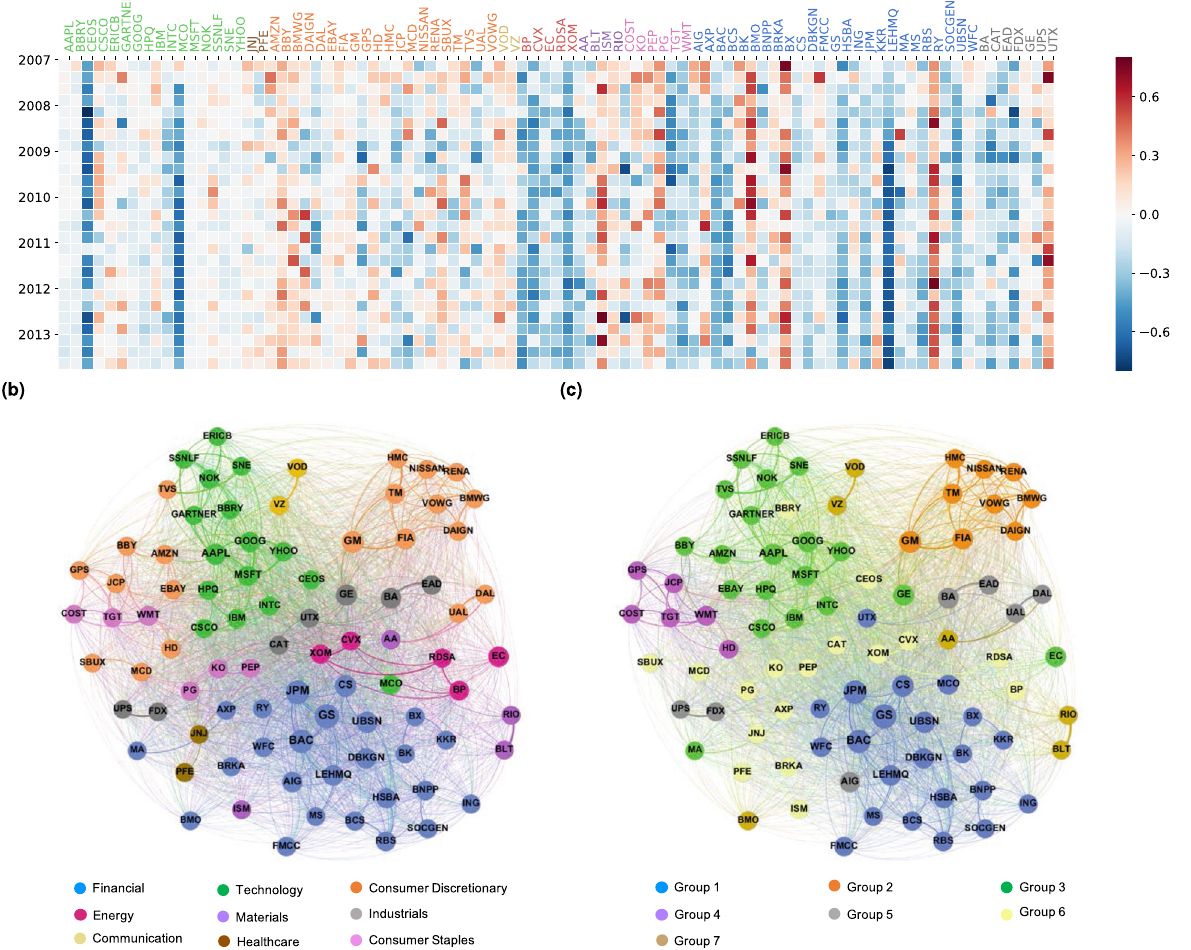
Figure 1. News co-occurrence network and sentiment distribution. ( a ) Sentiment distribution for 87 target companies in 27 quarters from 2007 to 2013. Colors in x-tick represent different sectors; ( b ) news co-occurrence network colored with sector; ( c ) news co-occurrence network colored with detected